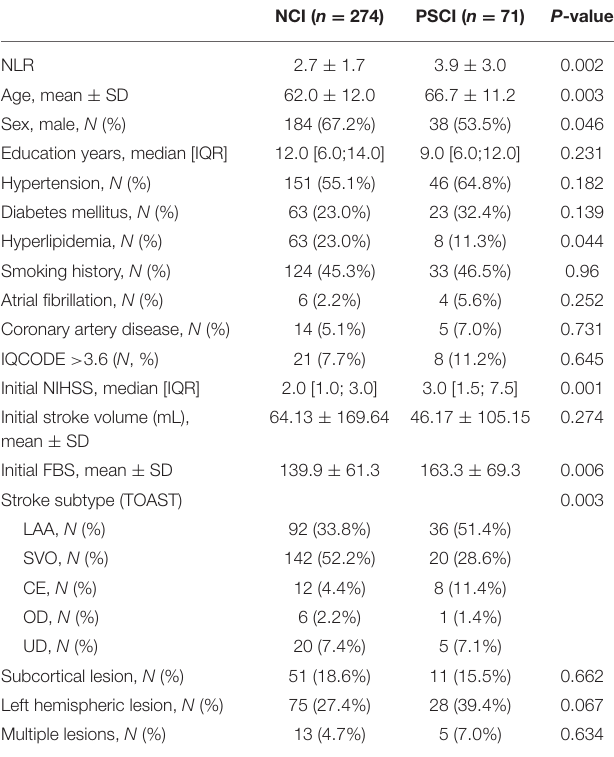
TABLE 1 | Baseline characteristics according to the presence of post-stroke cognitive impairment.